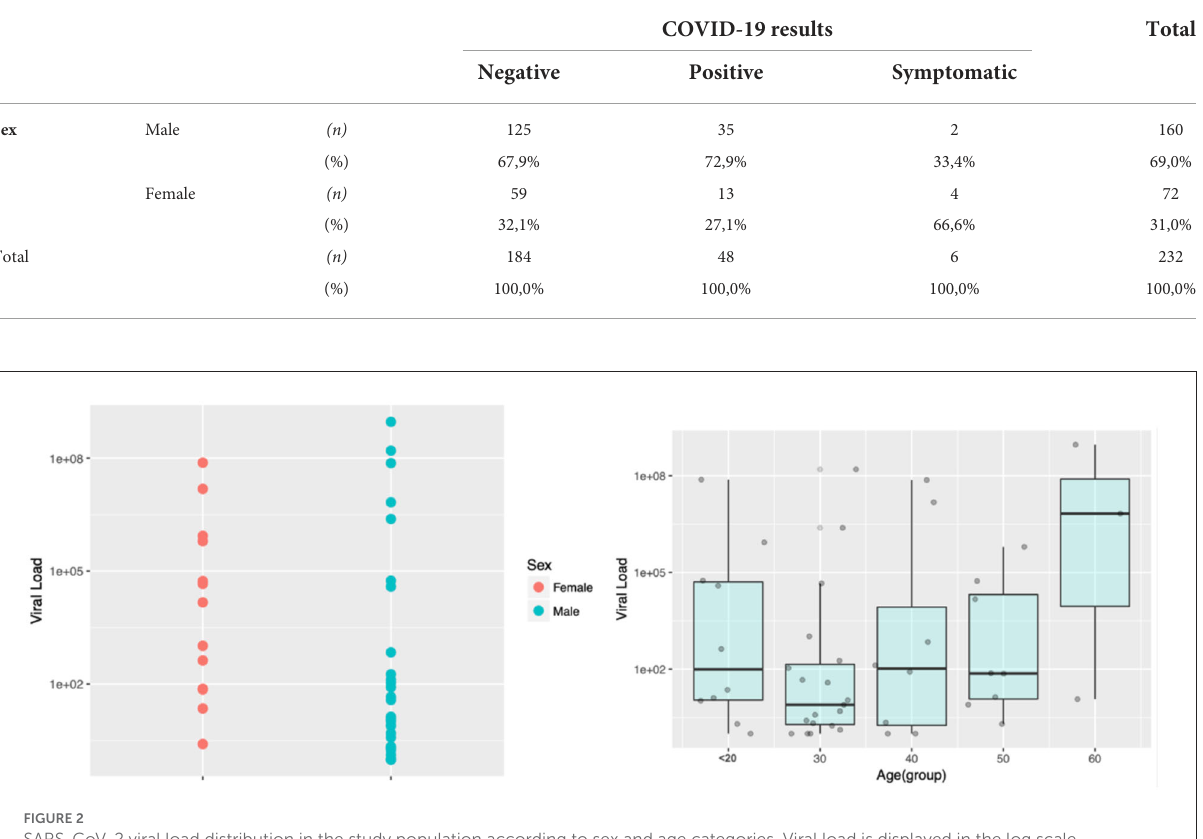
TABLE 1 Sociodemographic and symptomatology status among COVID-19 funeral home workers.